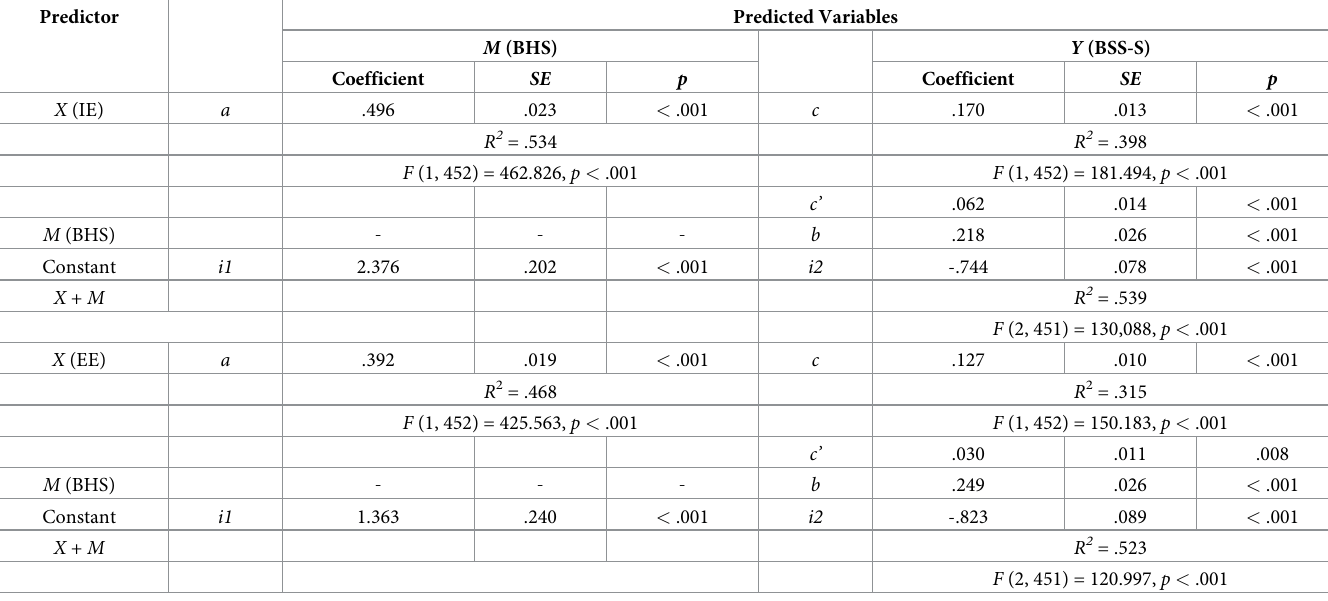
Table 3. Regression coefficients for the prediction of suicidal ideation.